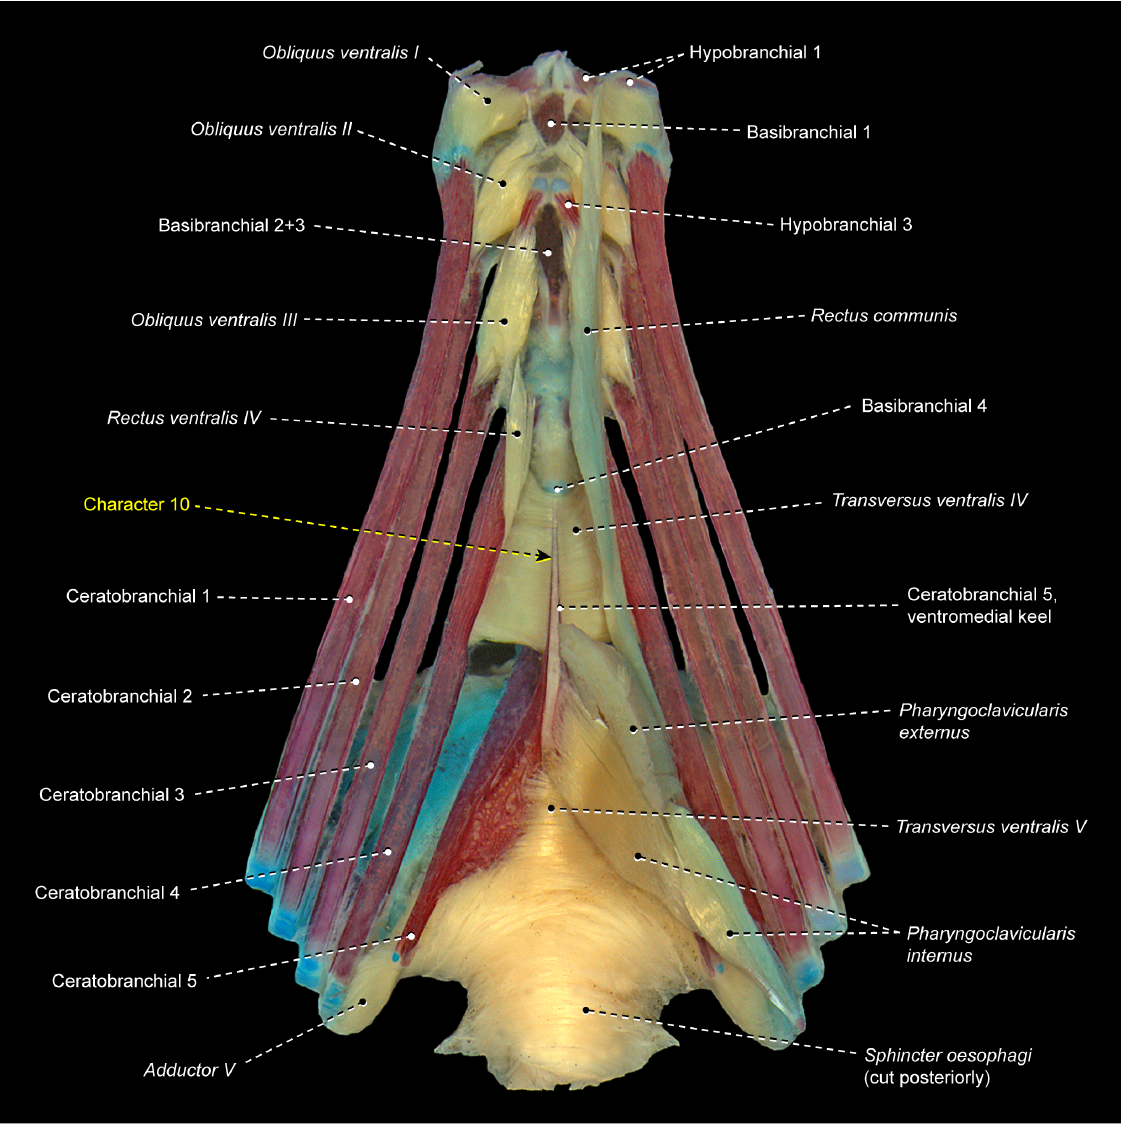
Figure 9. Branchial musculoskeletal system of Cichla cf. piquiti (Labriformes: Cichlidae). LIRP 6317. Ventral view; gill rakers and right pharyngoclavicularis externus , pharyngoclavicularis internus , and rectus communis removed.